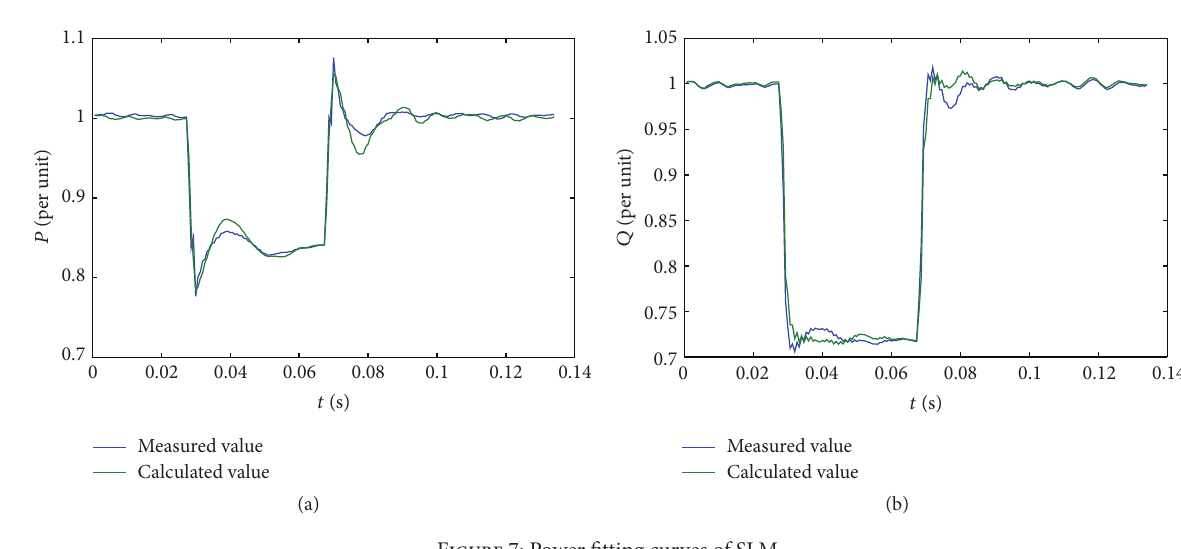
Figure 7: Power fitting curves of